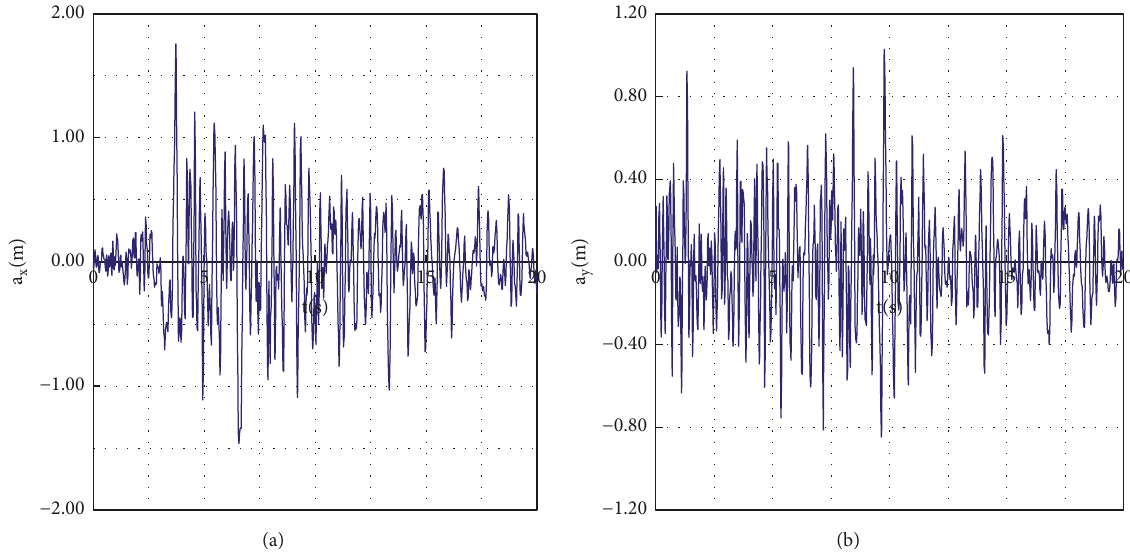
Figure 15: Acceleration time histories of Taft earthquake: (a) horizontal and (b) vertical.